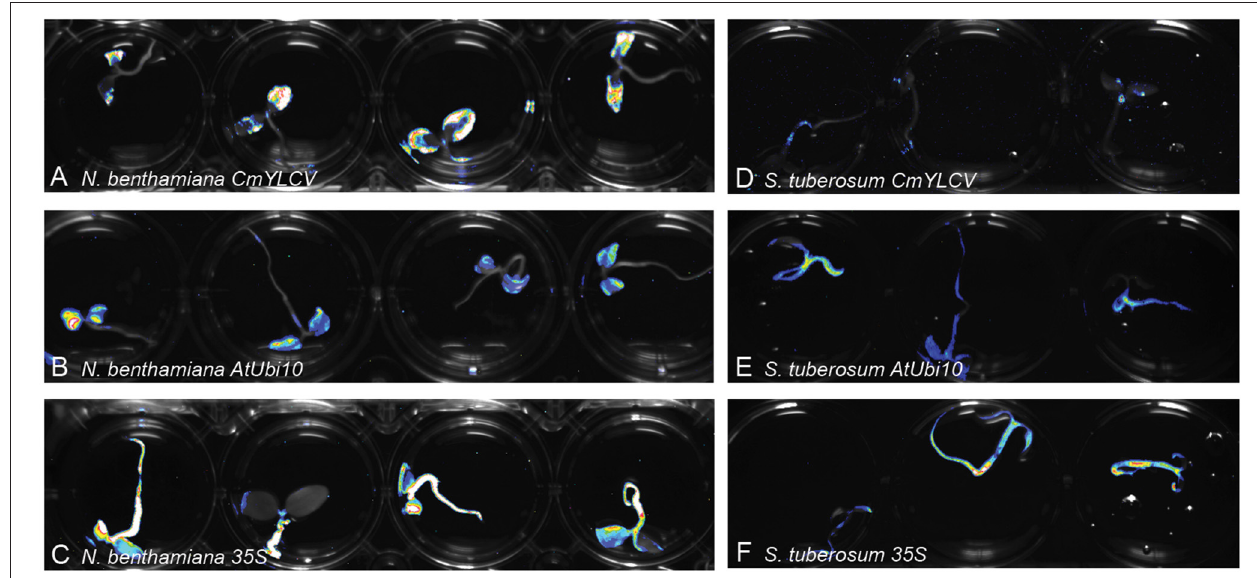
FIGURE 2 | Monitoring differences in promoter expression across species. Firefly luciferase expression was used to compare promoter activity in different species. Constructs encoding luciferase driven by the promoters CmYLCV (A,D) , AtUbi10 (B,E) , and 35S (C,F) were delivered to N. benthamiana (A–C) and potato (D–F) seedlings using Fast-TrACC. By taking long exposure images after delivery, promoter activity can be compared within a given species or across species. Expression patterns for each of the promoters was distinct. Out of the three tested promoters CmYLCV showed the greatest differences between species (A,D) . Testing new promoters to drive luciferase allows for their effectiveness to be determined in a species of interest.